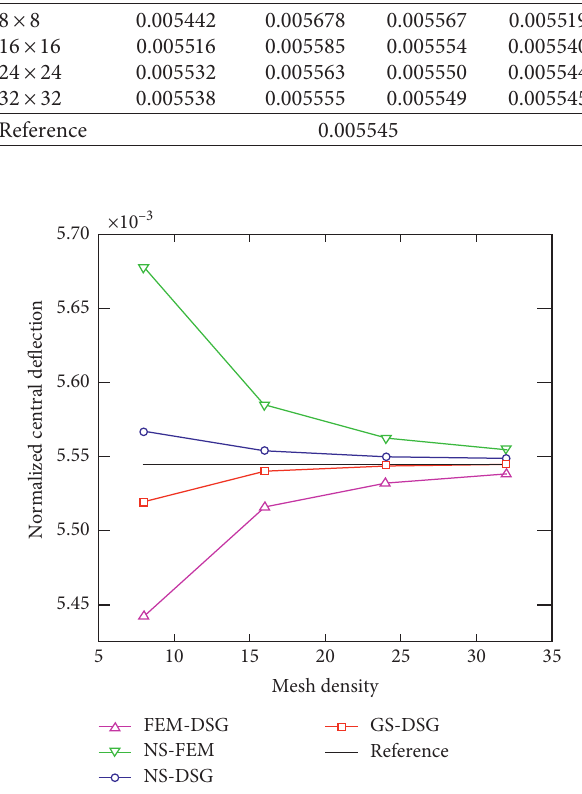
Figure 4: Central deflection.